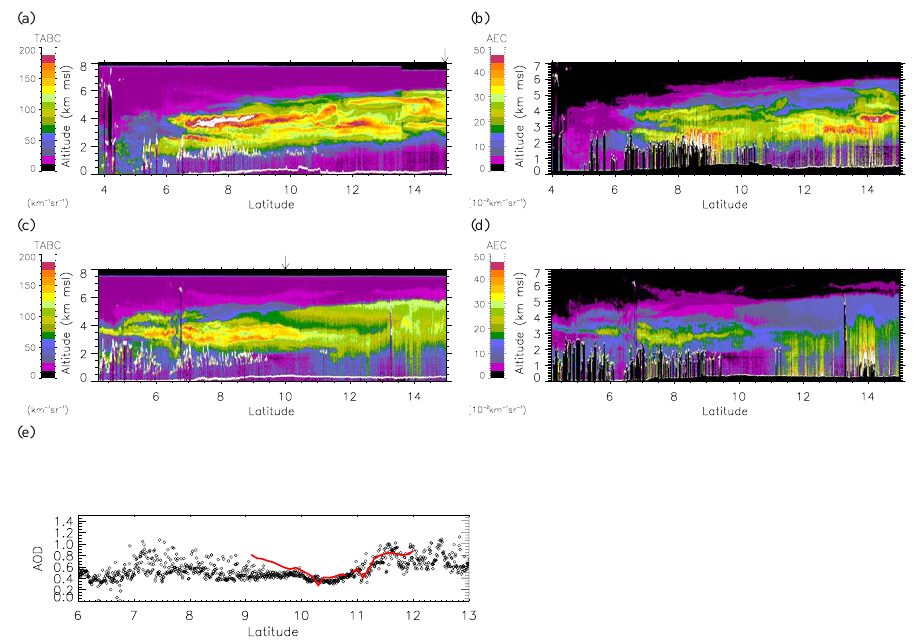
Fig. 6. LEANDRE-derived total attenuated backscatter coefficient (TABC) and LEANDRE-derived aerosol extinction (AEC) on 13 June ( a and b , respectively) and 14 June ( c and d , respectively). Clouds appear as areas with high TABC (white) above regions characterized by reduced TABC (blanks in AEC) as a result of attenuation between the cloud top and ground. (e) Aerosol optical depth from LEANDRE2 at 730 nm (diamonds) and MODIS at 670 nm (solid red line).